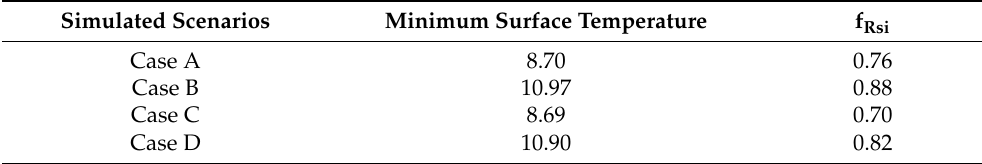
Table 9. Minimum surface temperature obtained from CFD simulation together with calculated f rsi